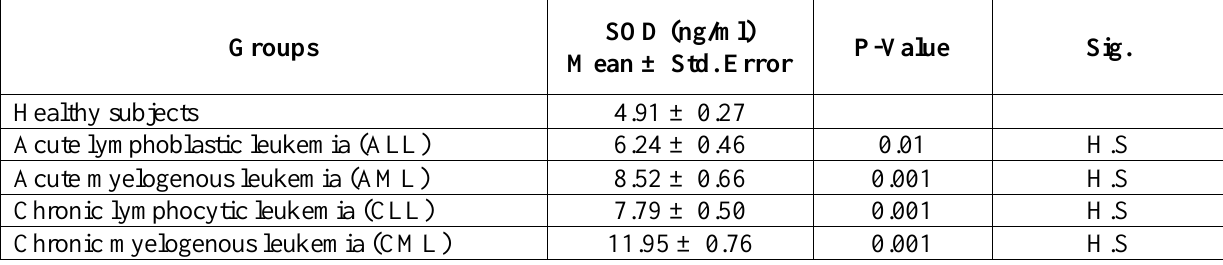
Figure 1 : Serum SOD levels in subtypes of leukemia and healthy subjects. Table 4: Serum levels of super oxide dismutase (Mean±SE) in different types of leukemia and healthy